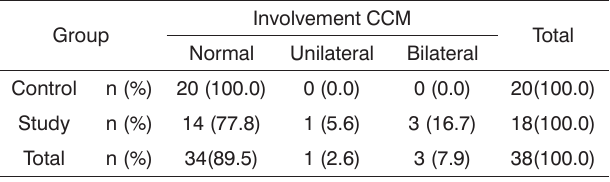
Table 2. Distribution of the control and study groups, in absolute (n) and relative (%) values, in relation to a disorder in the SSI test with CCM in the intensity between 0 and -40